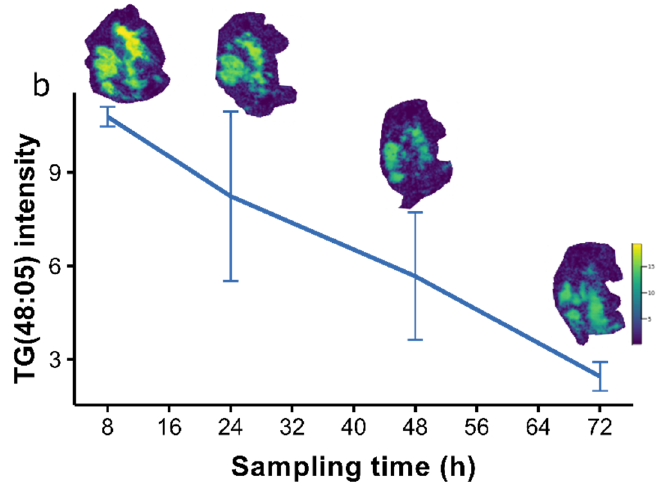
Figure 6. Line graphs showing the differences in the abundance of a representative phosphatidyl- choline and triacylglyceride; ( a ) PC(32:00) at m/z = 756.5521, and ( b ) TG(48:05) at m/z 835.6229, in Daphnia magna eggs across the seventh adult instar—specifically 8, 24, 48, and 72 h after the sixth brood. The error bars represent a 95% confidence interval. The ion images are overlaid on each plot to visualize the distribution of each lipid across the whole animal over time. The colour scale indicates the relative abundance of each lipid.